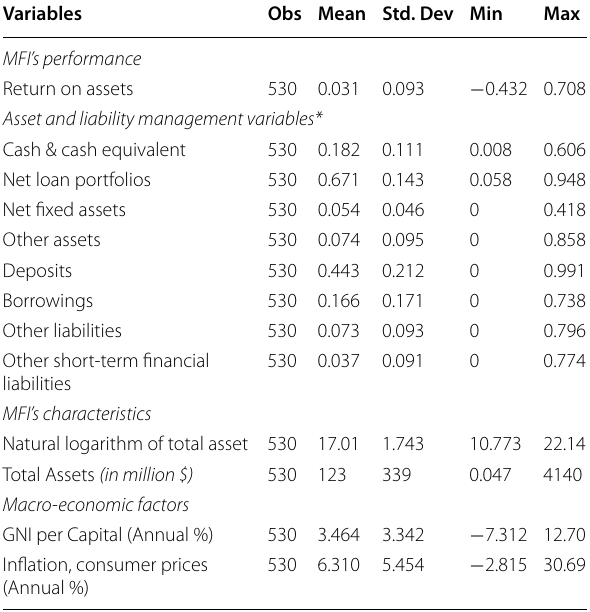
Table 2 Summary of statistics all variables. Source